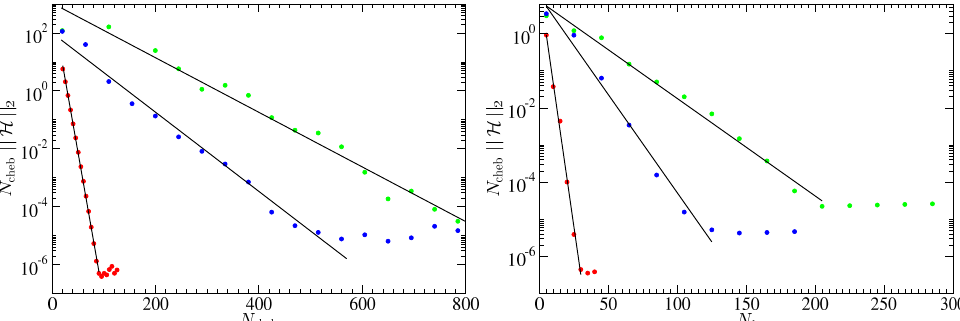
Figure 10. ( Left-panel ): Hamiltonian constraint for the numerical iterations of the bisection procedure in the case of a profile given by a Gaussian fluctuation for the supercritical case with Equation (83) and q = 1, λ = 0. ( Right-panel ): The same as the left panel, but for subcritical fluctuations. The initial Hamiltonian constraint is subtracted for each evolution of δ m in both cases.